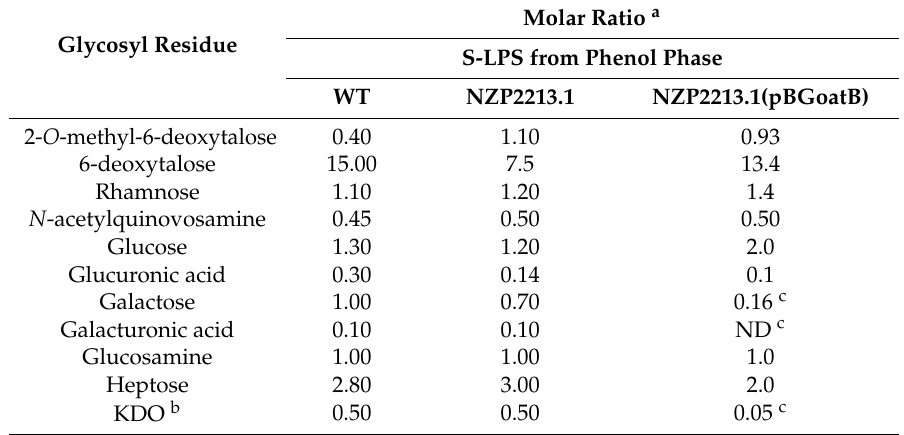
Table 1. Glycosyl composition of polysaccharide portions of M. loti WT, mutant NZP2213.1 and complemented NZP2213.1(pBGoatB)